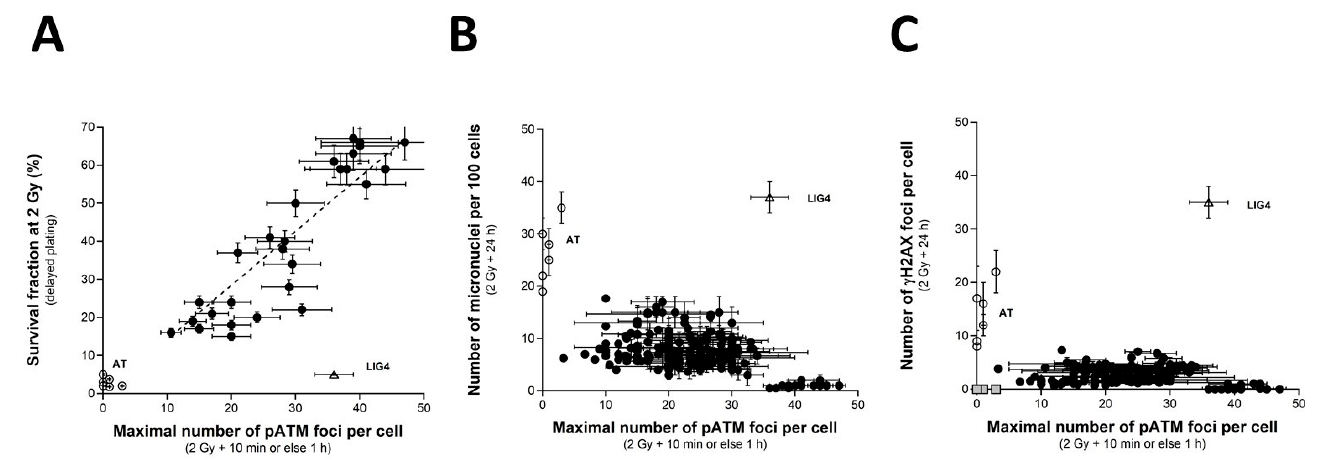
Figure 7. SF2 vs. pATMmax, pATmax vs. MN 24h and pATMmax vs. H2AX 24h relationships. ( A ) The SF2 data from 36 COPERNIC cell lines were plotted against the corresponding number of γ H2AX foci per cell assessed 24 h post-irradiation (closed circles). Each point corresponds to the mean ± standard error of the mean (SEM) of three independent triplicates, at least. The best data fit was obtained with the linear law: SF2 (pATMmax) = 1.422 × pATMmax; r 2 = 0.87 (dotted line). ( B ) The pATMmax from 200 COPERNIC cells were plotted against the corresponding number of micronuclei assessed 24 h post-irradiation ( B ) or the corresponding number of micronuclei assessed 24 h post-irradiation ( C ) Each point corresponds to the mean ± standard error of the mean (SEM) of three independent triplicates, at least. The grey square indicates all the AT data if considering γ H2AX foci in ATM -mutated cells as absent. The points corresponding to the ATM - (open circles) and the LIG4 - (open triangles) mutated cell lines are indicated.